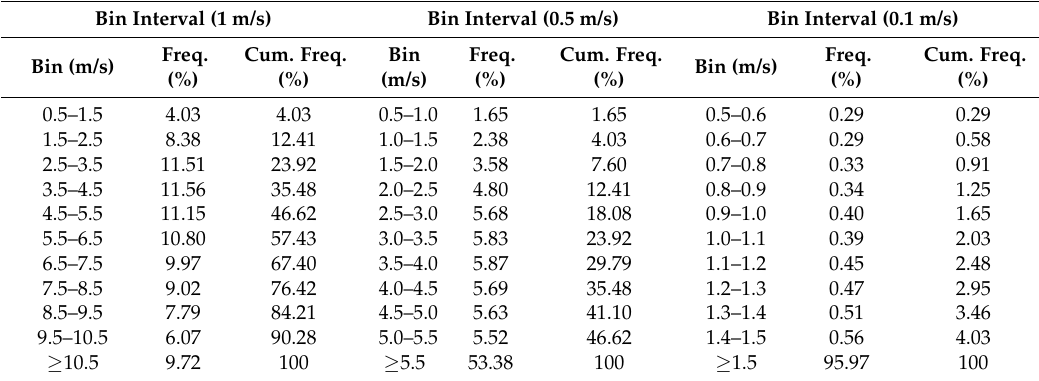
Table 3. The sample data set (site: Gapado). Cum.: Cumulative; Freq.: Frequency.